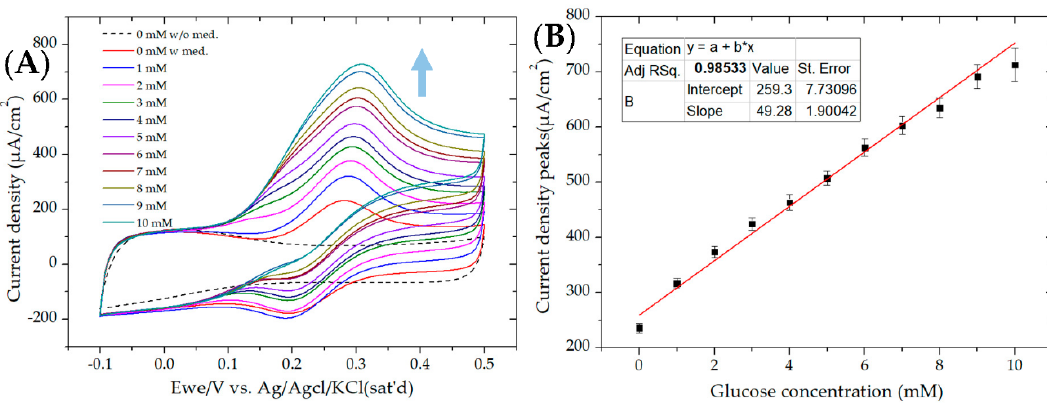
Figure 2. ( A ) Cyclic voltammograms of a glucose oxidase (GOx)-modified bioanode during the successive addition of varying glucose concentrations at 0 mM without a mediator (dashed curve) and 0–10 mM with a mediator (solid curves) in a sodium phosphate buffer (50 mM; pH 7) at a scan rate of 10 mV/sec. The arrow indicates increasing glucose concentration. ( B ) Corresponding calibration curve of the current density peaks at different glucose concentrations with a coefficient of correlation of R 2 = 0.985.